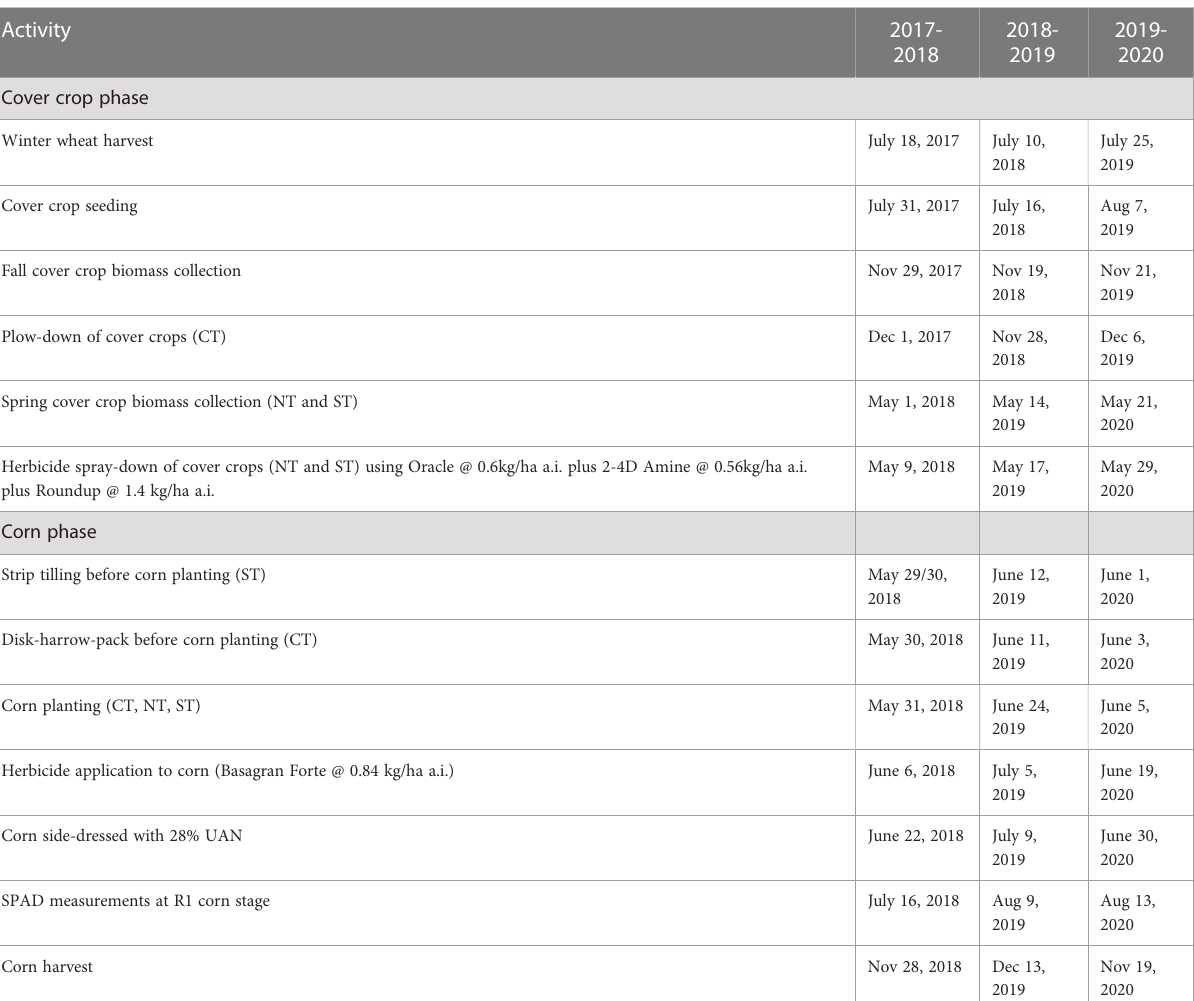
TABLE 1 Major agronomic